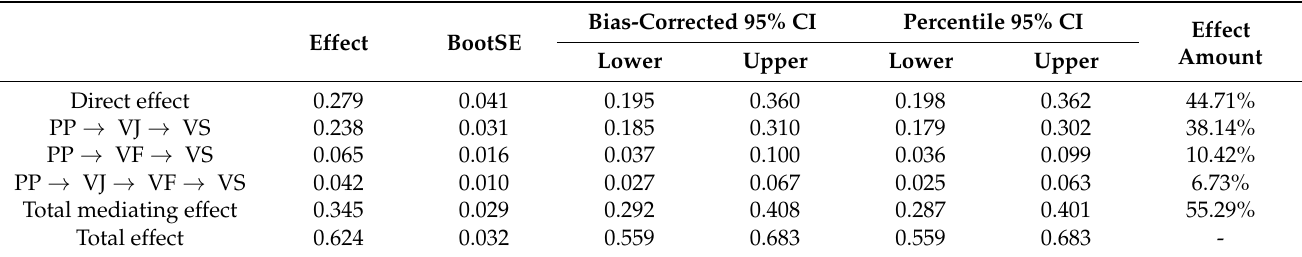
Table 7. Results of the mediating-effect